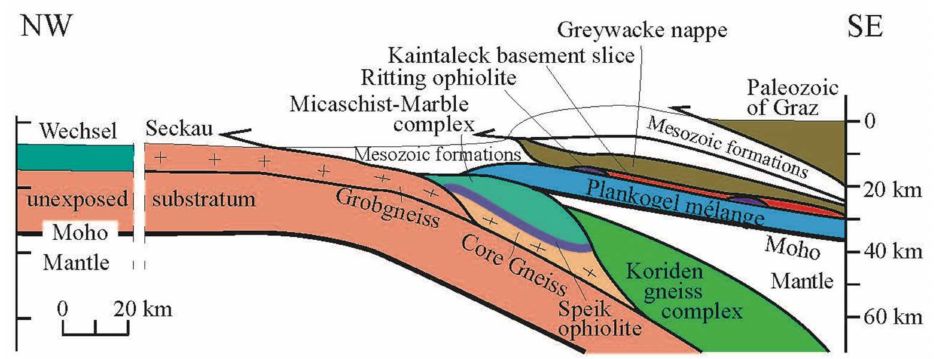
Figure 10. Crustal scale cross-section of the Austroalpine nappe stack during the Cretaceous (Eo- Alpine) event. The underlying plate consists of the Seckau, “Core” Gneiss and Grobgneiss complexes. The Wechsel Complex is assumed to belong to the same plate. The Speik ophiolite separates this piece of continental crust below, and an upper one formed by the Micaschist–marble and Koriden–gneiss complexes. The post-Variscan Plankogel ophiolitic m é lange separates this lower edifice from an upper one formed by the Ritting ophiolites, the Neoproterozoic Kaintaleck basement and the low-grade metamorphic units (Greywacke nappe, and Paleozoic of Graz). The Mesozoic units are left in white (modified from